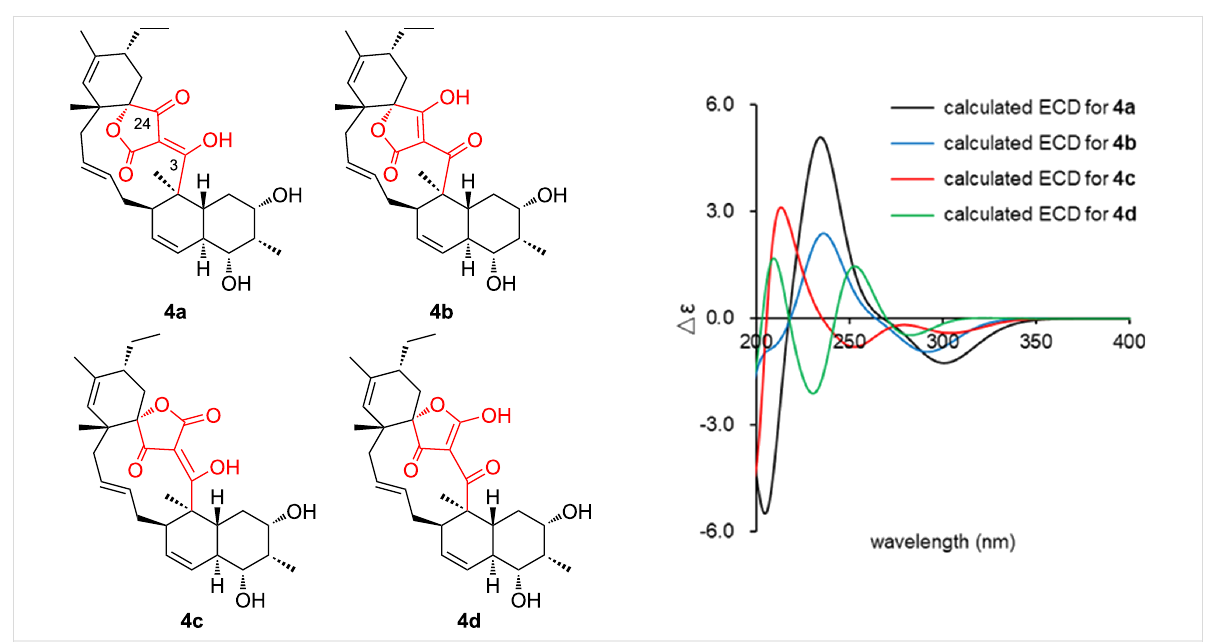
Figure 5: Four tautomers 4a – 4d of the tetronic acid moiety of 4 and calculated ECD spectra.